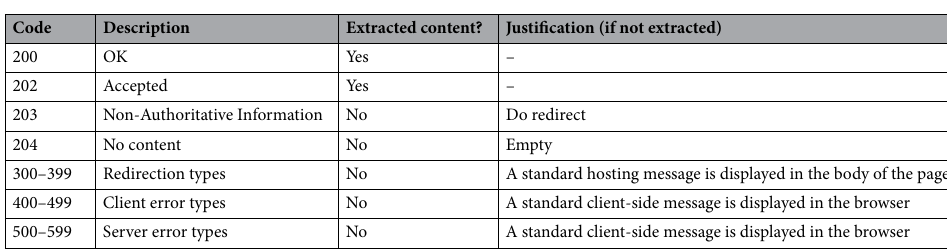
Table 8. HTTP Status code parsed for extracting page